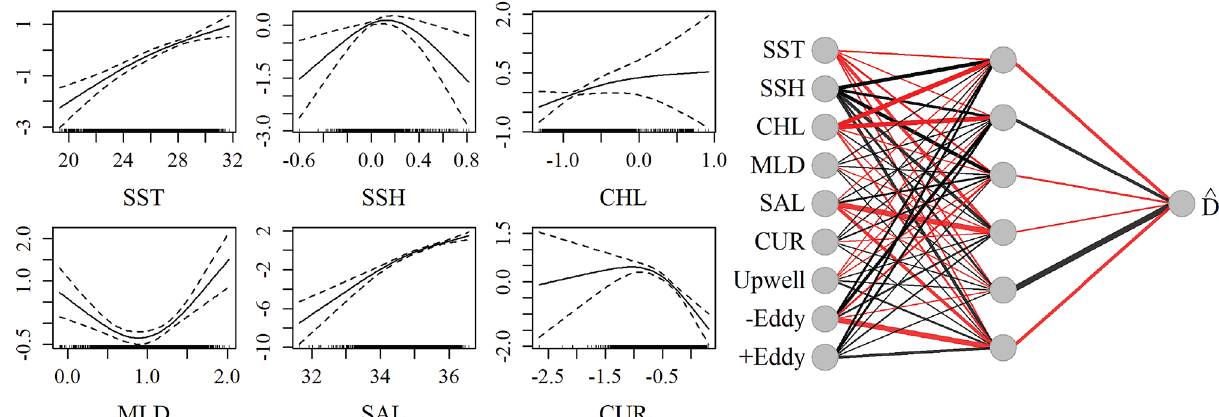
Figure 3. Influence of predictor variables in the best fitting Cuvier’s beaked whale models. Left : Smooths of significant terms in the joint GAM. Right : Neural network for Cuvier’s beaked whale acoustic-only model with four nodes (gray circles) in the hidden layer. Lines indicate connections between nodes, with thicker lines indicating higher weights. Black lines represent positive weights and red lines represent negative weights.